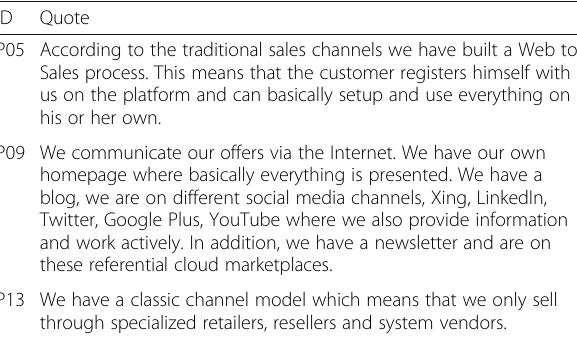
Table 4 Quotes related to the design of the sales